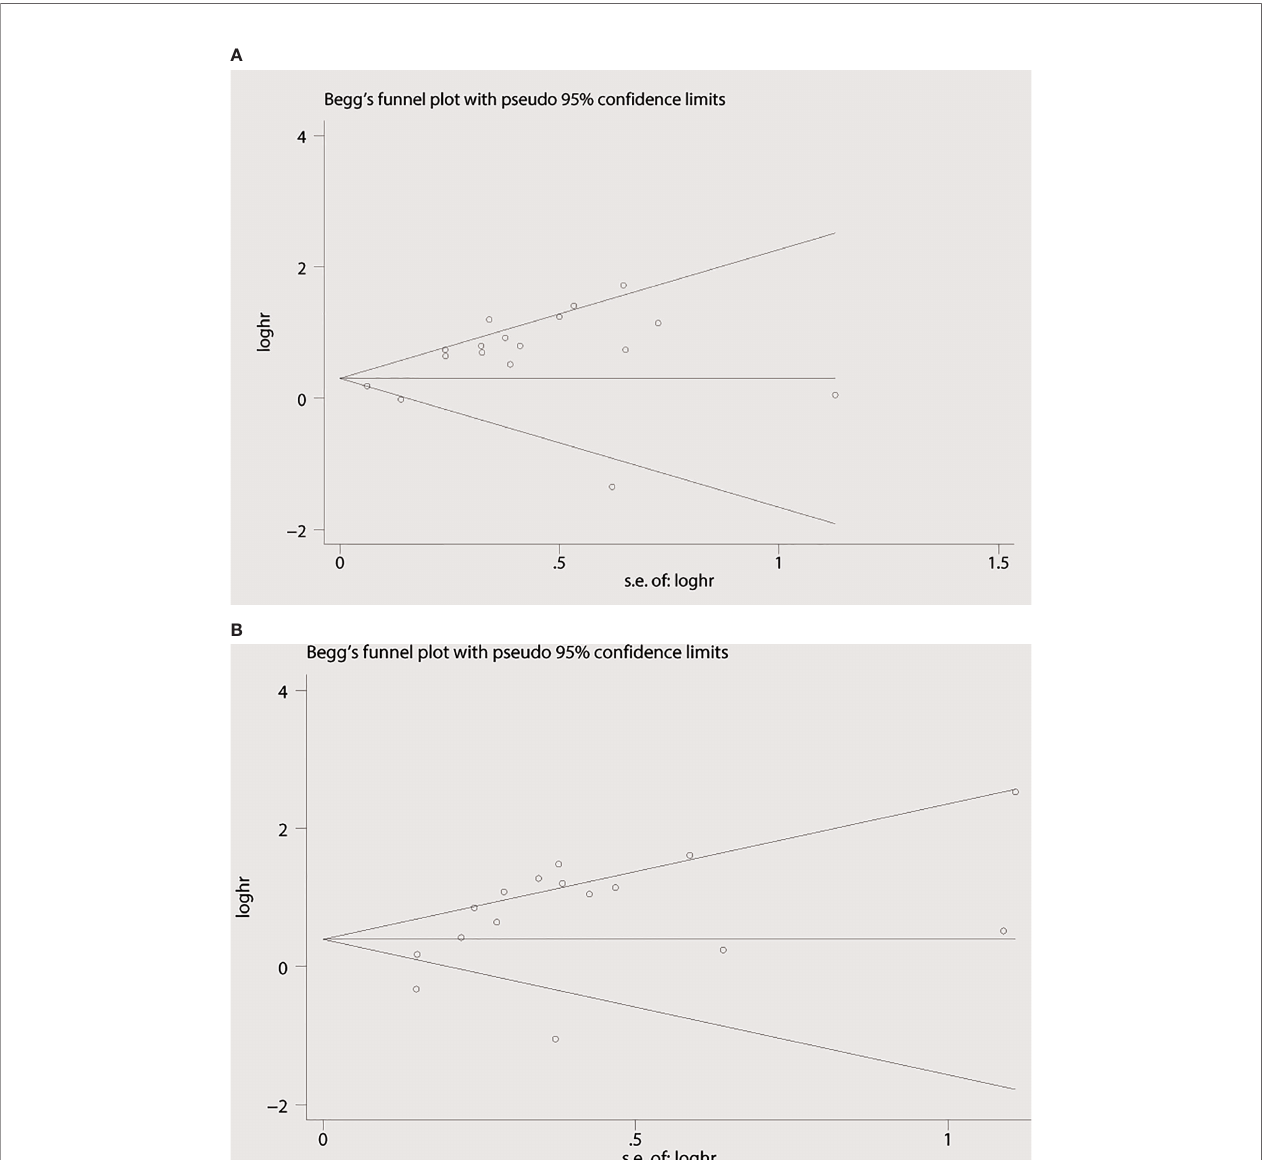
FIGURE 4 | Begg ’ s funnel plots for the studies involved in the meta-analysis. (A) Overall survival. (B) Time to progression (TTP). loghr, logarithm of hazard ratios; s.e., standard